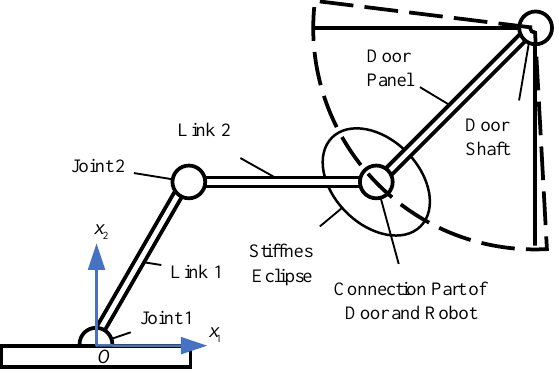
Figure 11. The scene of the door-opening task. The two-link robot with two revolute joints needs to opening a door with unknown length and